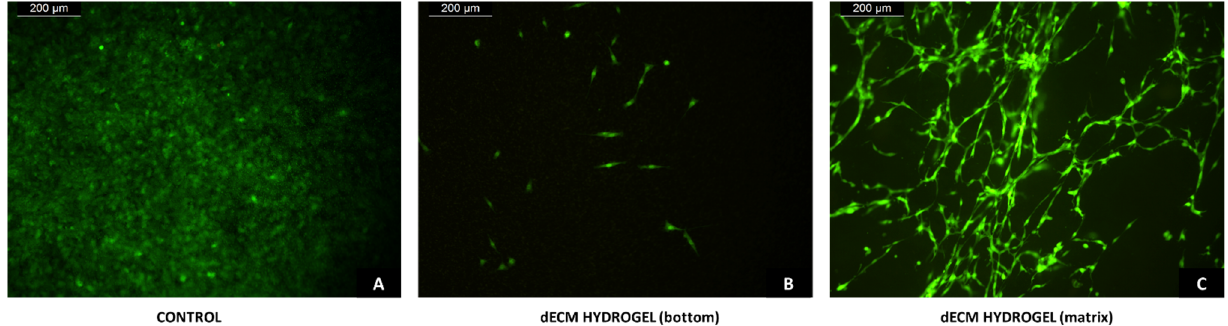
Figure 8. Transwell fibroblast migration. ( A , B ) NIH-GFP at the bottom of control and dECM hydrogel transwells after 7 days from seeding. ( C ) Migrated NIH-GFP inside the 4 mg/mL dECM hydrogel after 7 days from seeding. Magnification 10×. Scale bar 200 μ m.